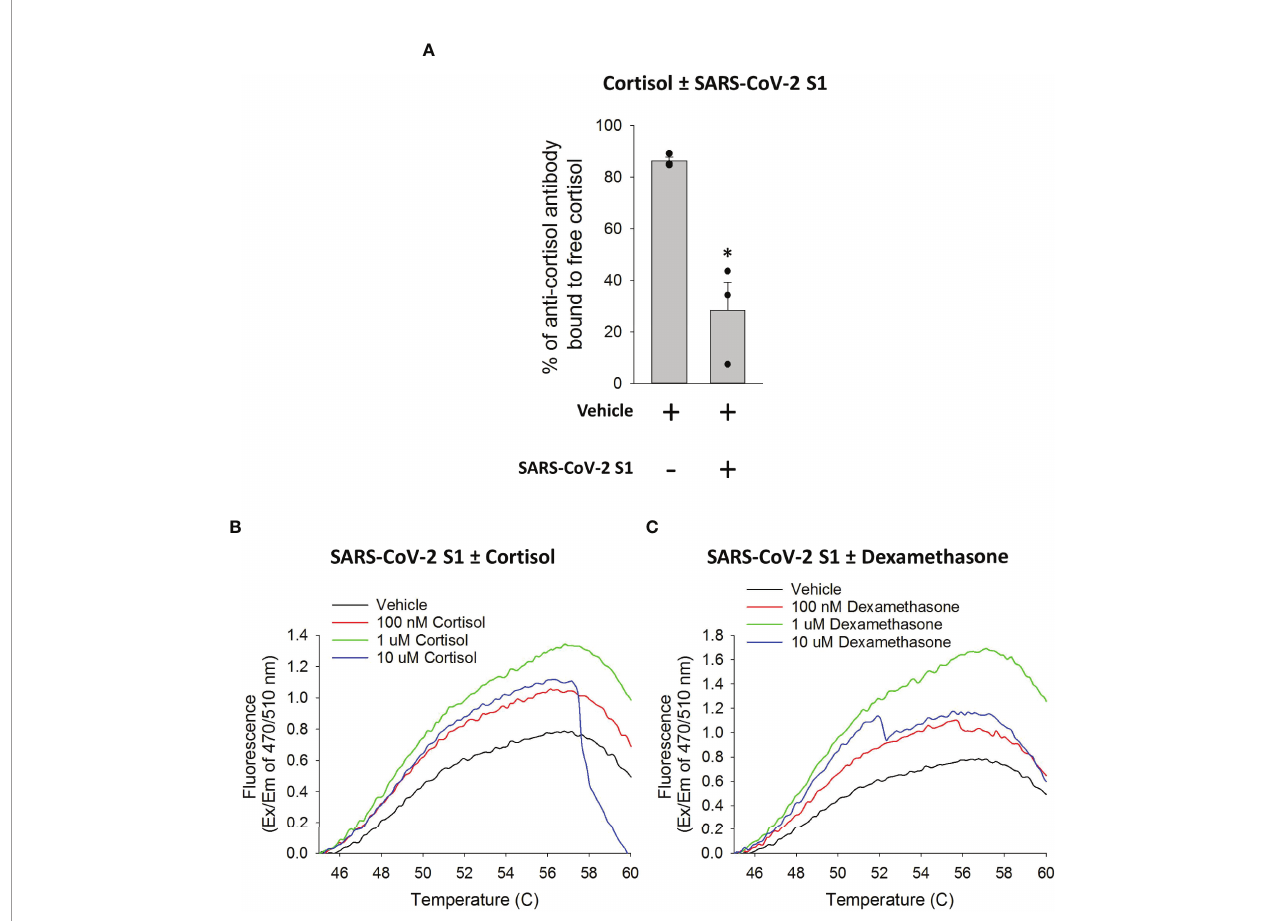
FIGURE 4 | Cortisol directly binds SARS-CoV-2 S1 protein. (A) Bar graph showing a decrease in free cortisol in solution in the presence of SARS-CoV-2 S1. Cortisol was incubated with vehicle or SARS-CoV-2 S1 and the sample mixtures were fi ltered to collect unbound free cortisol in the fl ow through. The quantity of cortisol in the fl ow through from the samples was determined as the percentage of anti-cortisol antibody bound to cortisol as opposed to a competitor cortisol- acetylcholinesterase conjugate. Data presented as mean ± standard error (n = 3). * P < 0.05 vs vehicle (1-way ANOVA). (B, C) Line plots generated using GloMelt ™ Thermal Shift Protein Stability assay showing unfolding (represented by increase in fl uorescence) of SARS-CoV-2 S1 at increasing temperatures in the presence or absence of increasing concentrations of cortisol or dexamethasone (100 nM, 1 µM, 10 µM). Data for high concentrations (10 µM) of either cortisol or dexamethasone suggest formations of aggregates in the aqueous conditions of the assay (as indicated by the decay of the signal). Data are representative of two independent